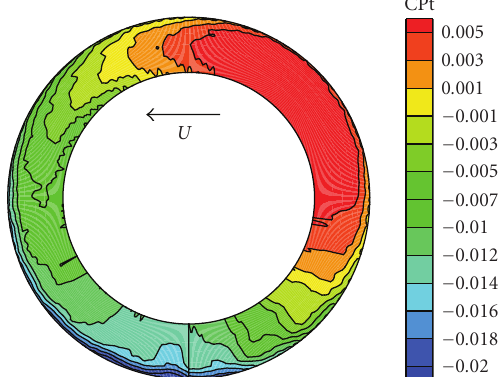
Figure 7: Total pressure coe ffi cient section e.